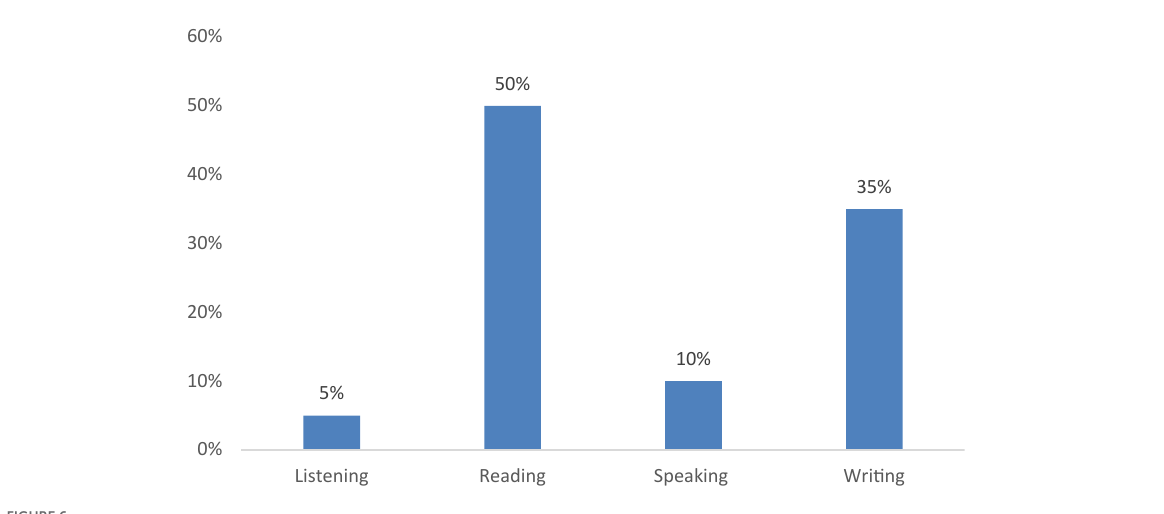
FIGURE6 Most useful categories of Elevate language training according to group 1 (author’s data).